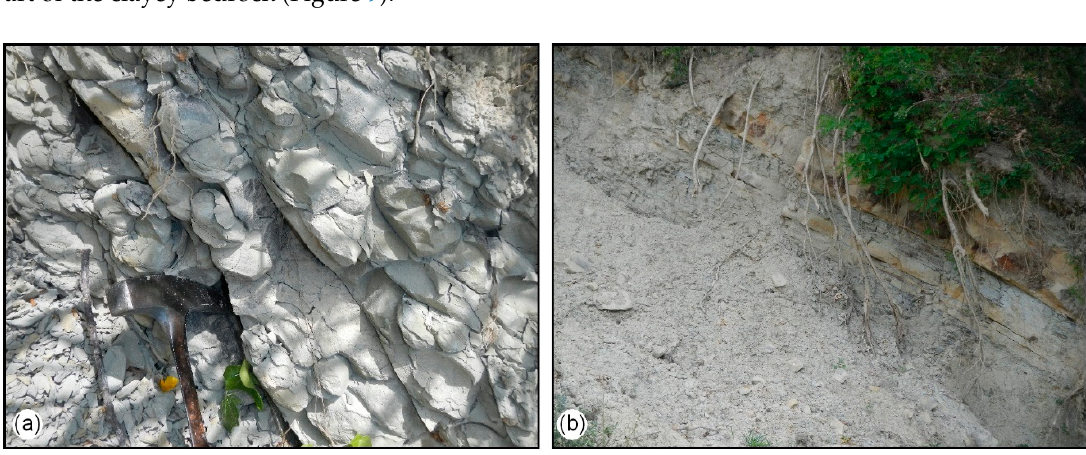
Figure 7. Lithological features of the bedrock arenaceous layers in the Ponzano area: ( a ) thick sandstone layers; ( b ) alternating sandstone layers with thin clay levels.